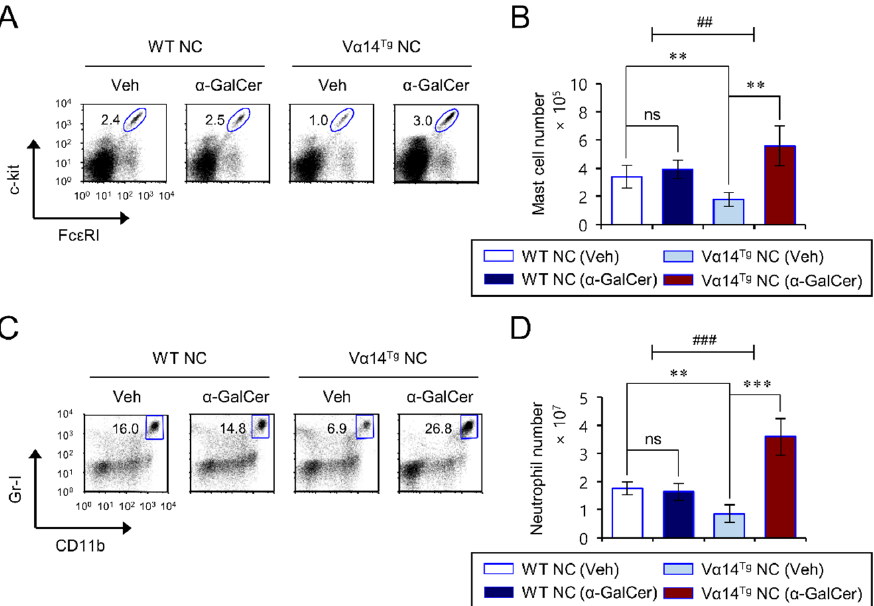
Figure 4. Repeated α -GalCer-injection expands splenic mast cells and neutrophils in V α 14 Tg NC mice. Spleens were prepared from mice as shown in Figure 1. ( A , B ) The frequency ( A ) and cell number ( B ) of mast cells (Fc ε RI + c-kit + CD3 − CD19 − ) were determined by flow cytometry. ( C , D ) The frequency ( C ) and cell number ( D ) of neutrophils (CD11b + Gr-1 + CD3 − CD19 − ) were determined by flow cytometry. The mean values ± SD ( n = 4 in ( A – D ); per group in the experiment; Student’s t -test; ** p < 0.01, *** p < 0.001) are shown. Two-way ANOVA (V α 14 TCR Tg × α -GalCer) showed